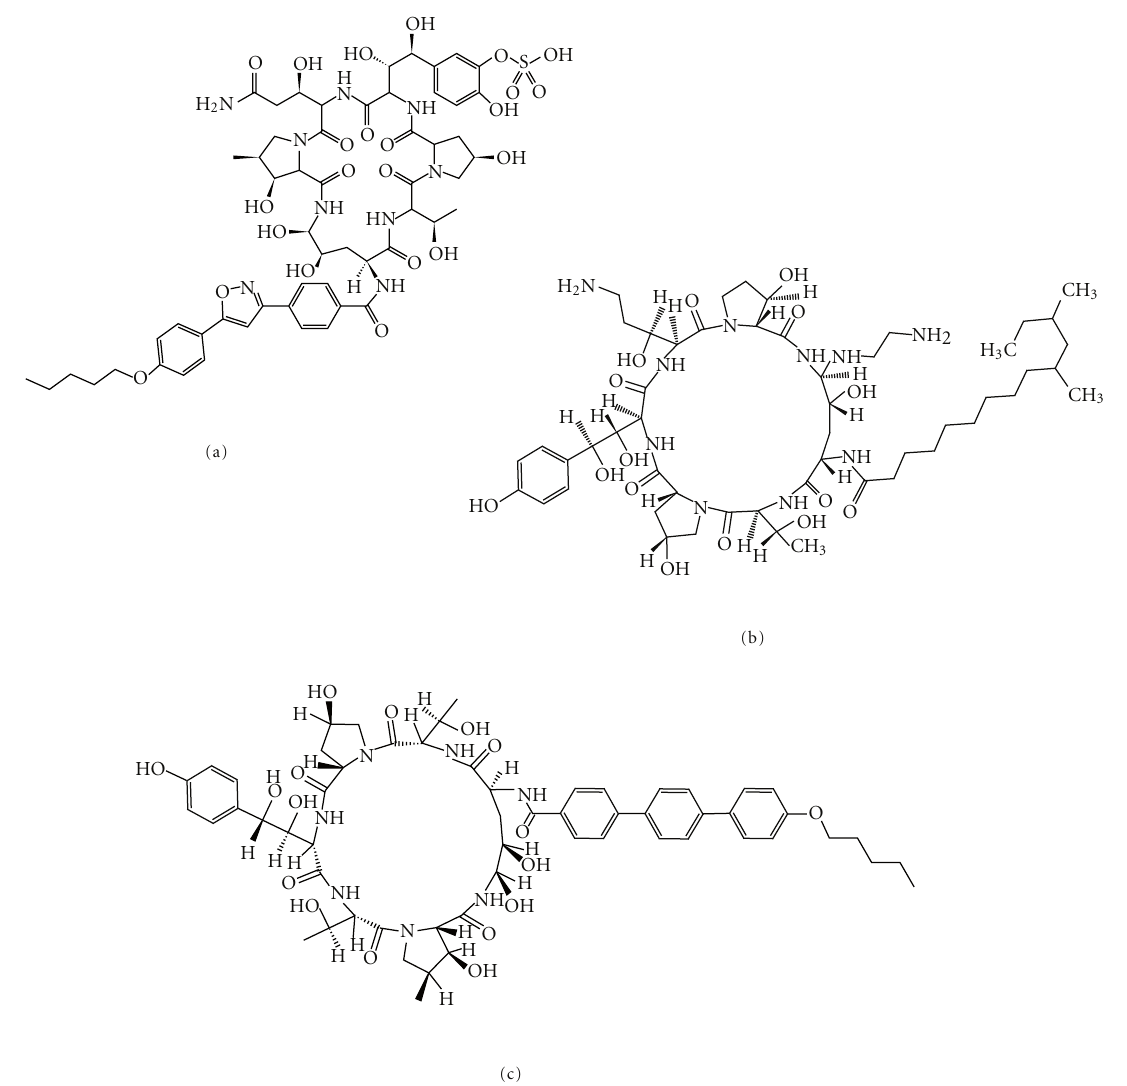
Figure 6: Chemical structure of the three echinocandins used in clinical practice: micafungin (a), caspofungin (b), and anidulafungin (c).